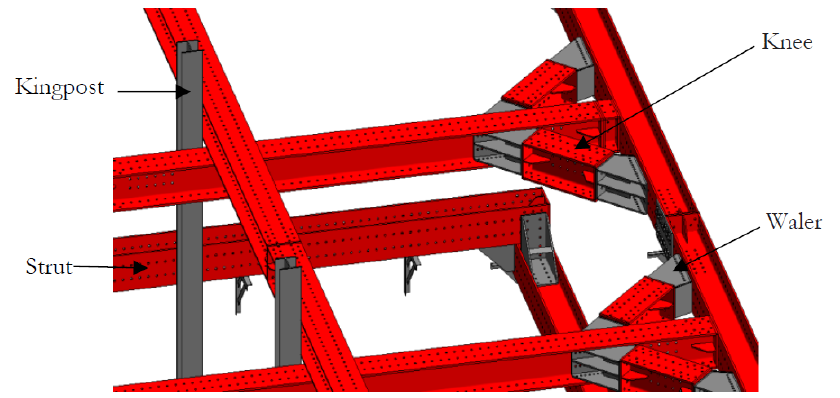
Figure 1. Components of the strutting system.